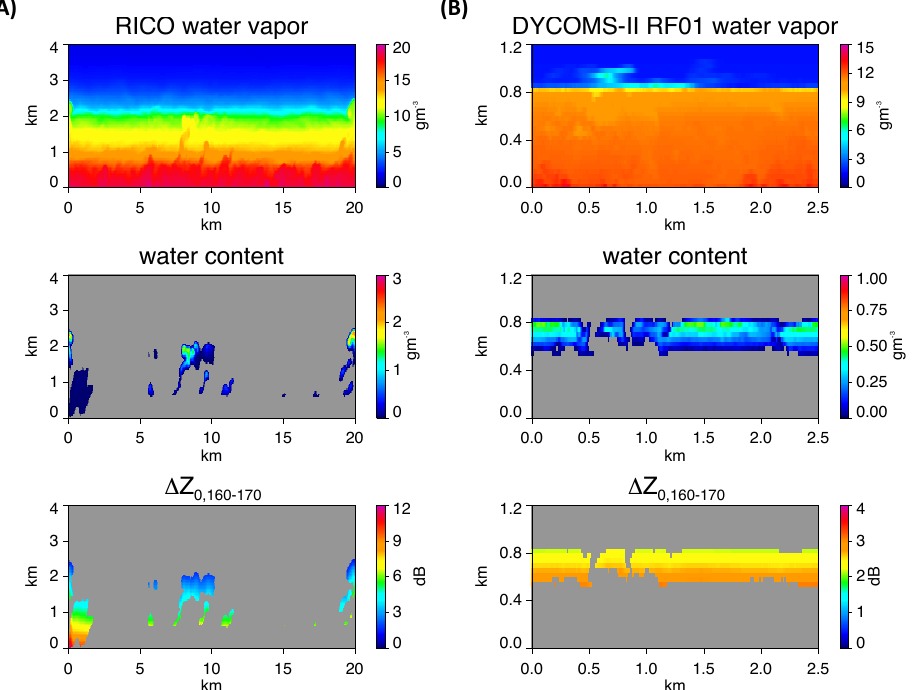
Figure 5. Cross sections of water vapor, total liquid water content and the reflectivity difference between 160 and 170GHz for RICO (a) and DYCOMS-II RF01 (b)